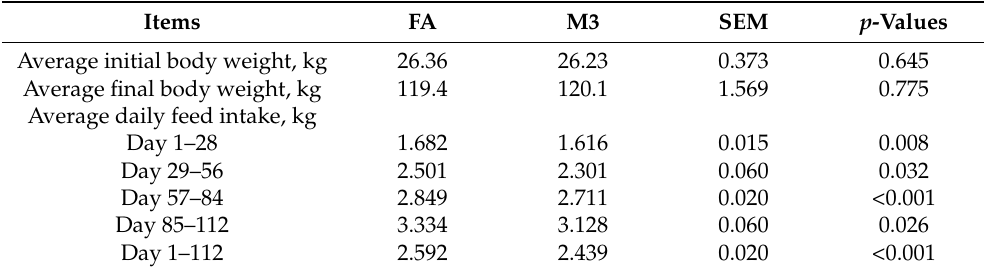
Table 3. Effects of feeding frequency on growth performance in growing–finishing